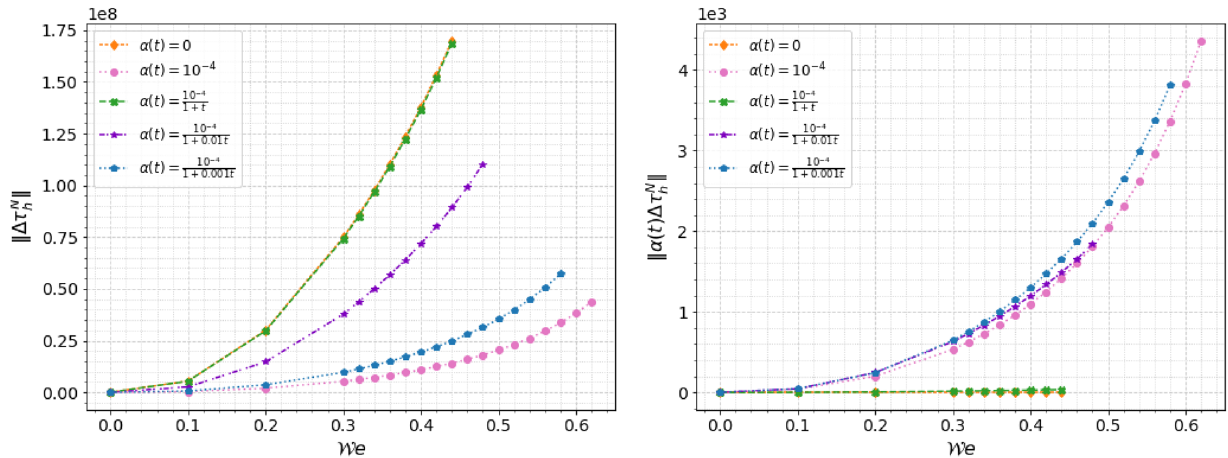
)Δ 𝝉 n Δ 𝝉 n 𝛼 ( 𝜙 (left) and (right) for different values of parameter 𝜀 of diffusion coefficient 𝜀 of 𝛼 ( t ) = 10 − 4 t ‖ ‖ ‖ ‖